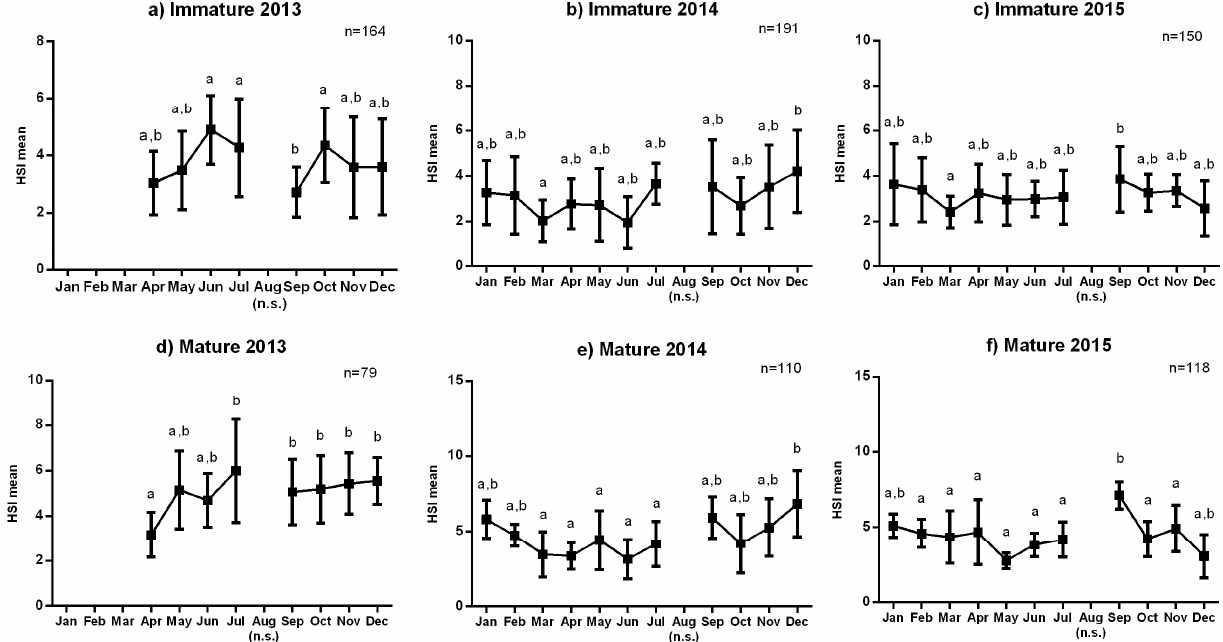
Figure 3. Monthly variation of European hake female hepatosomatic index (HSI) for three years in different ovarian stages. Graphics ( a – c ) indicate the females in the immature phase, while graphics ( d – f ) show females from developing to regenerating phase. From January to March of 2013, no sampling of the liver was conducted. In August of the three years no samples (n.s.) were sampled. The letters indicate a statistically significant difference among groups ( p < 0.05) determined by Tukey’s multiple comparison test.